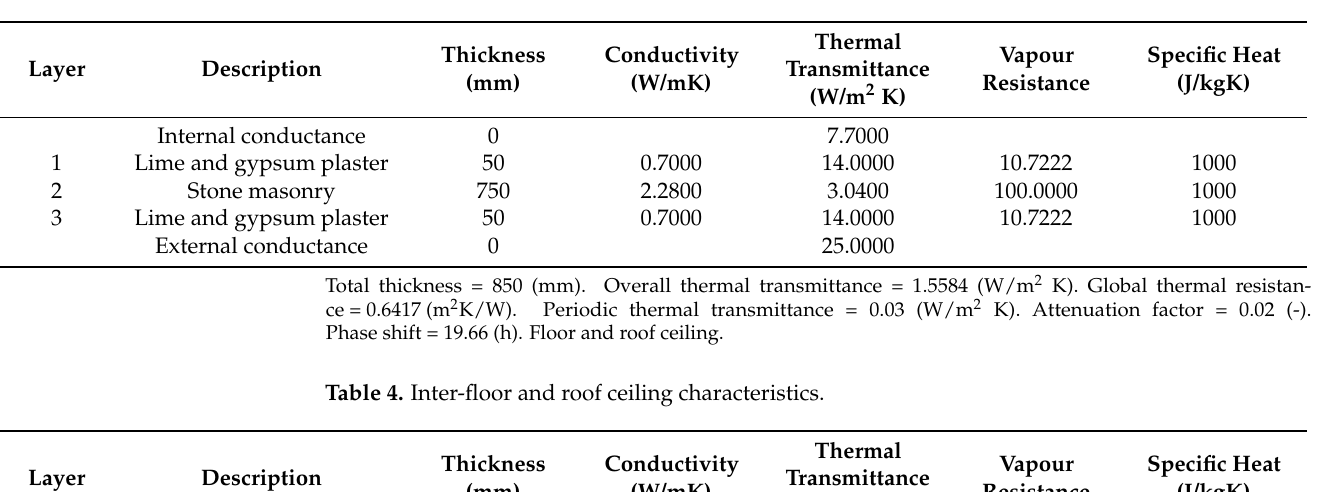
Table 3. Floor on ground characteristics.